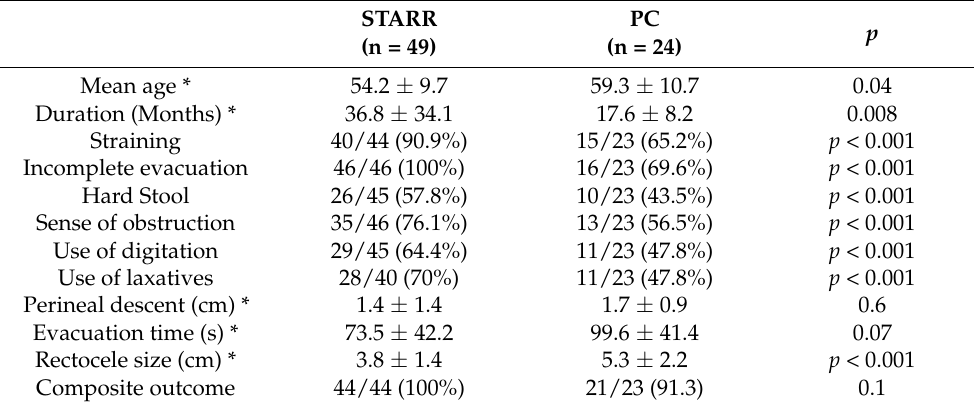
Table 2. Preoperative evaluation of the study